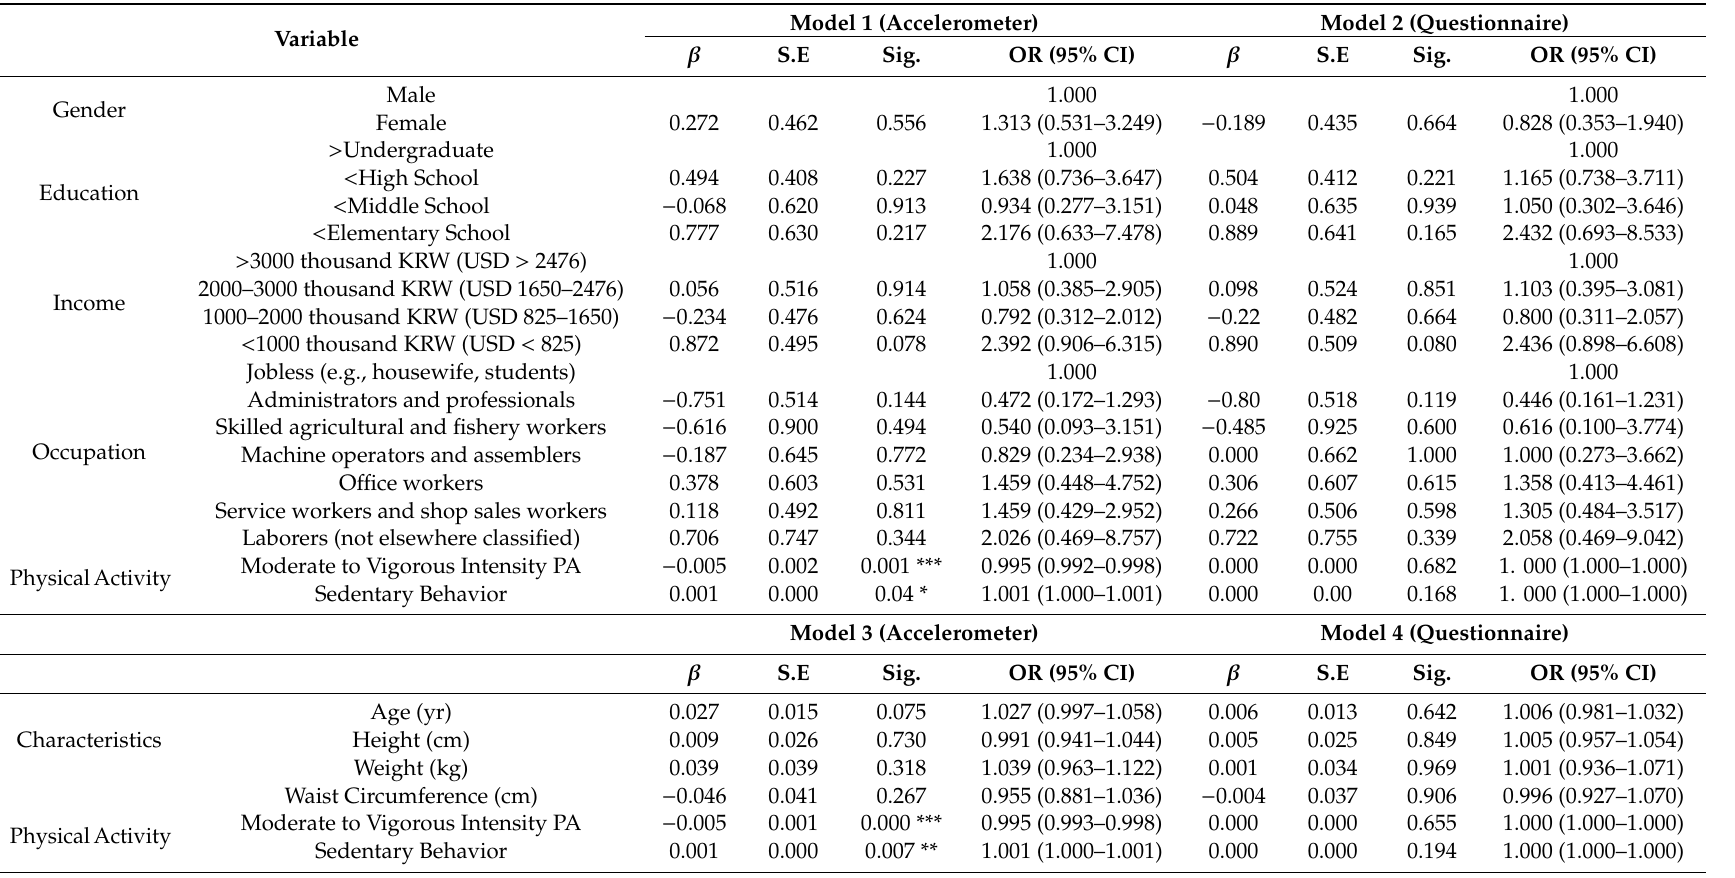
Table 2. Multinomial logistic regression of risk factors related to suicidal behaviors between the two